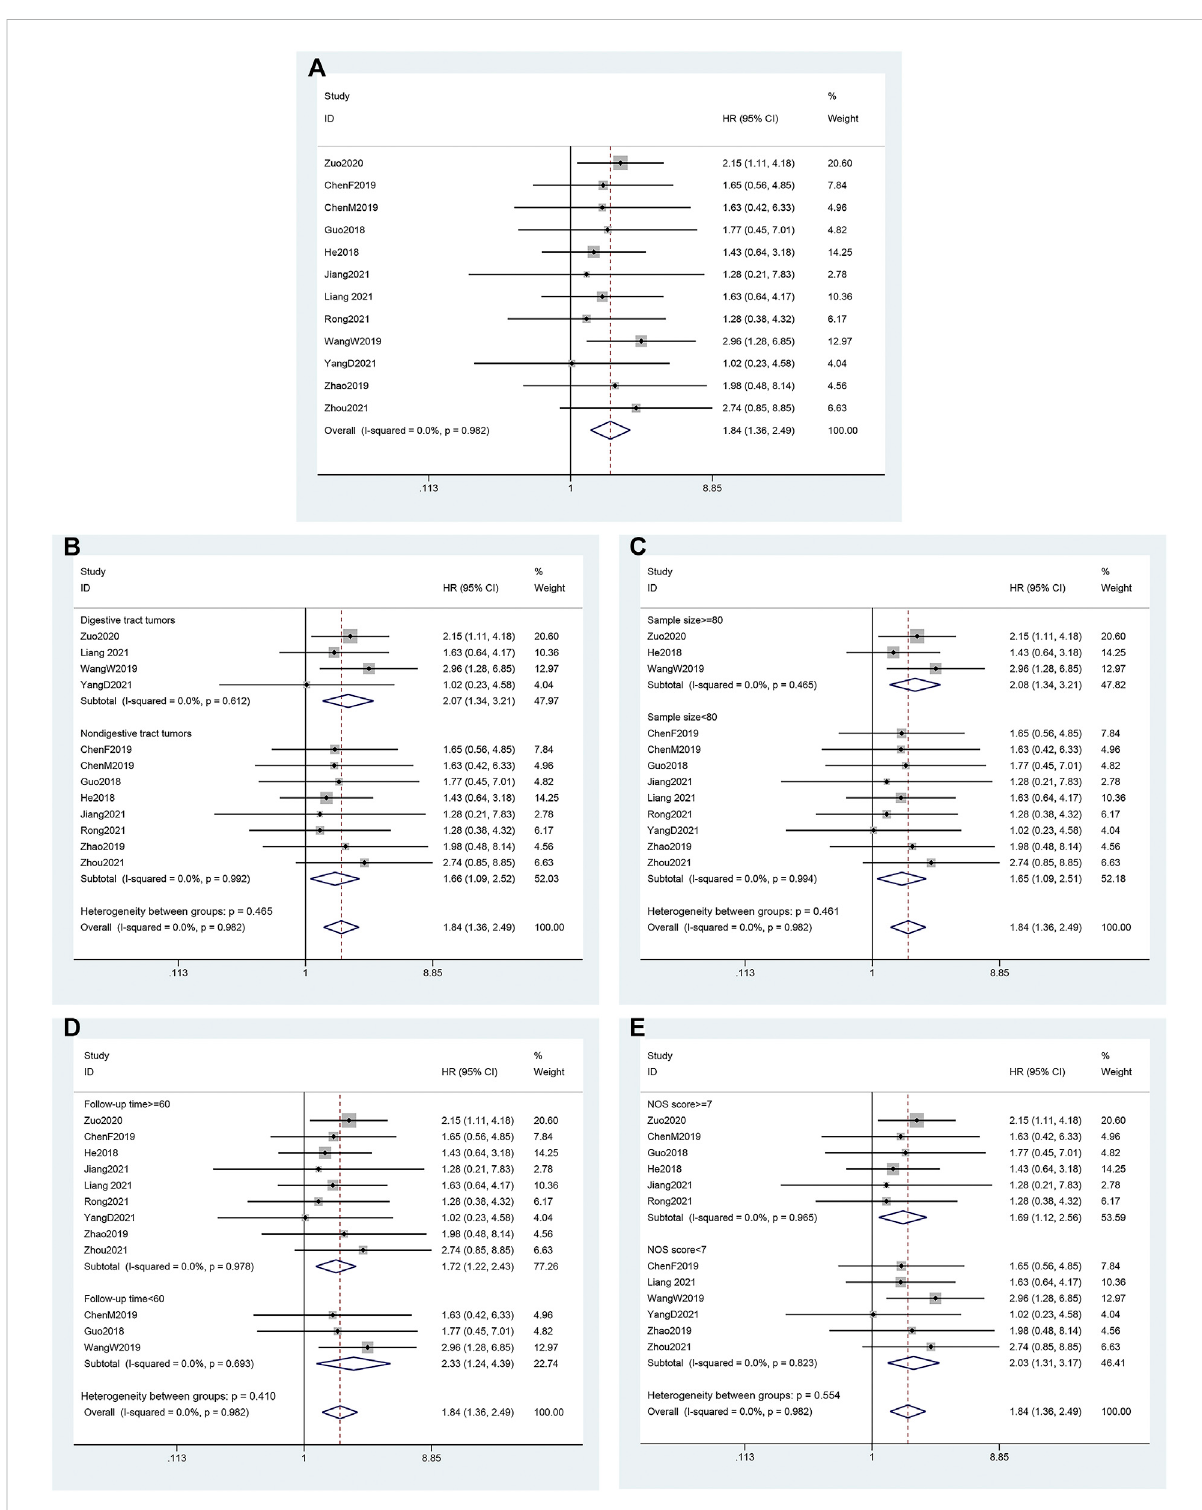
FIGURE 2 Association of LINC00958 expression with overall survival. (A) Forest plots for an association of LINC00958 expression with overall survival. (B) Subgroup analysis strati fi ed by cancer type. (C) Subgroup analysis strati fi ed by sample size. (D) Subgroup analysis strati fi ed by follow-up time. (E) Subgroup analysis strati fi ed by NOS